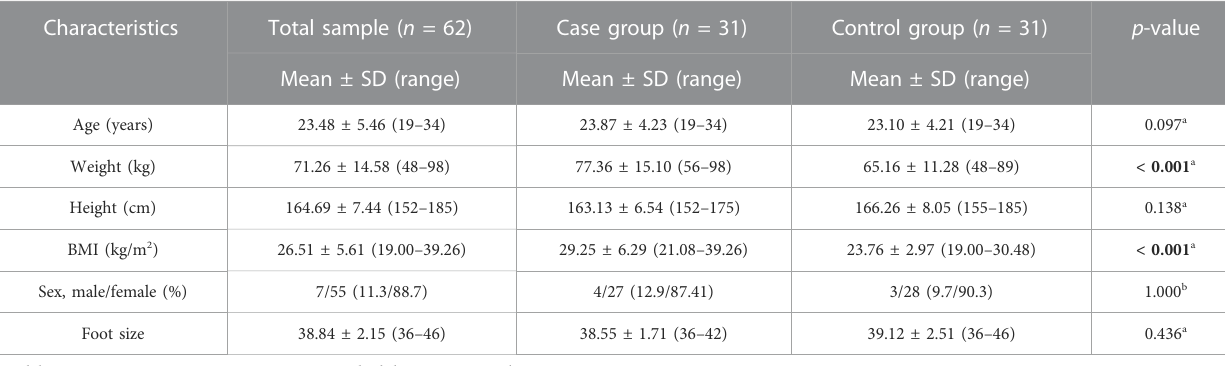
TABLE 1 Main characteristics of the total sample with or without bilateral adult fl